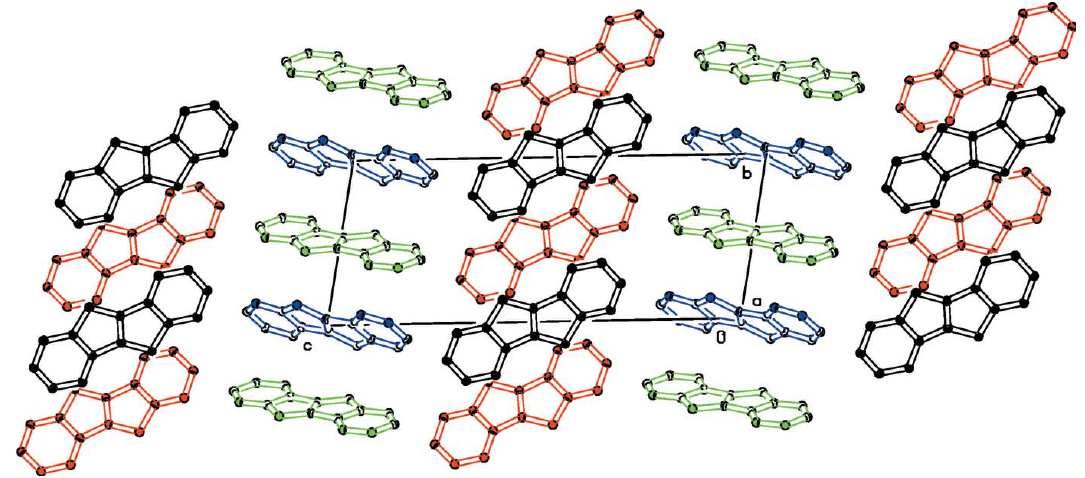
Figure 2 Packing diagram of the title compound viewed along the a axis. Symmetry-independent molecules are drawn with different